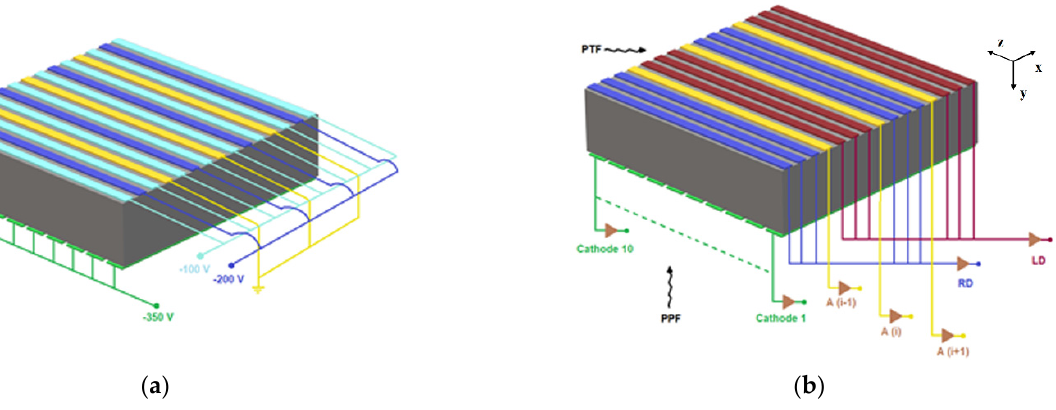
Figure 1. ( a ) Electrical scheme of the bias voltage setting for the anode the cathode strips. ( b ) The signal read − out setting and the irradiation geometries: planar parallel field (PPF) and planar transverse field (PTF). The PTF geometry allows a detection area of 6 × 20 mm 2 (X − Y plane) and a photon interaction depth of 20 mm.